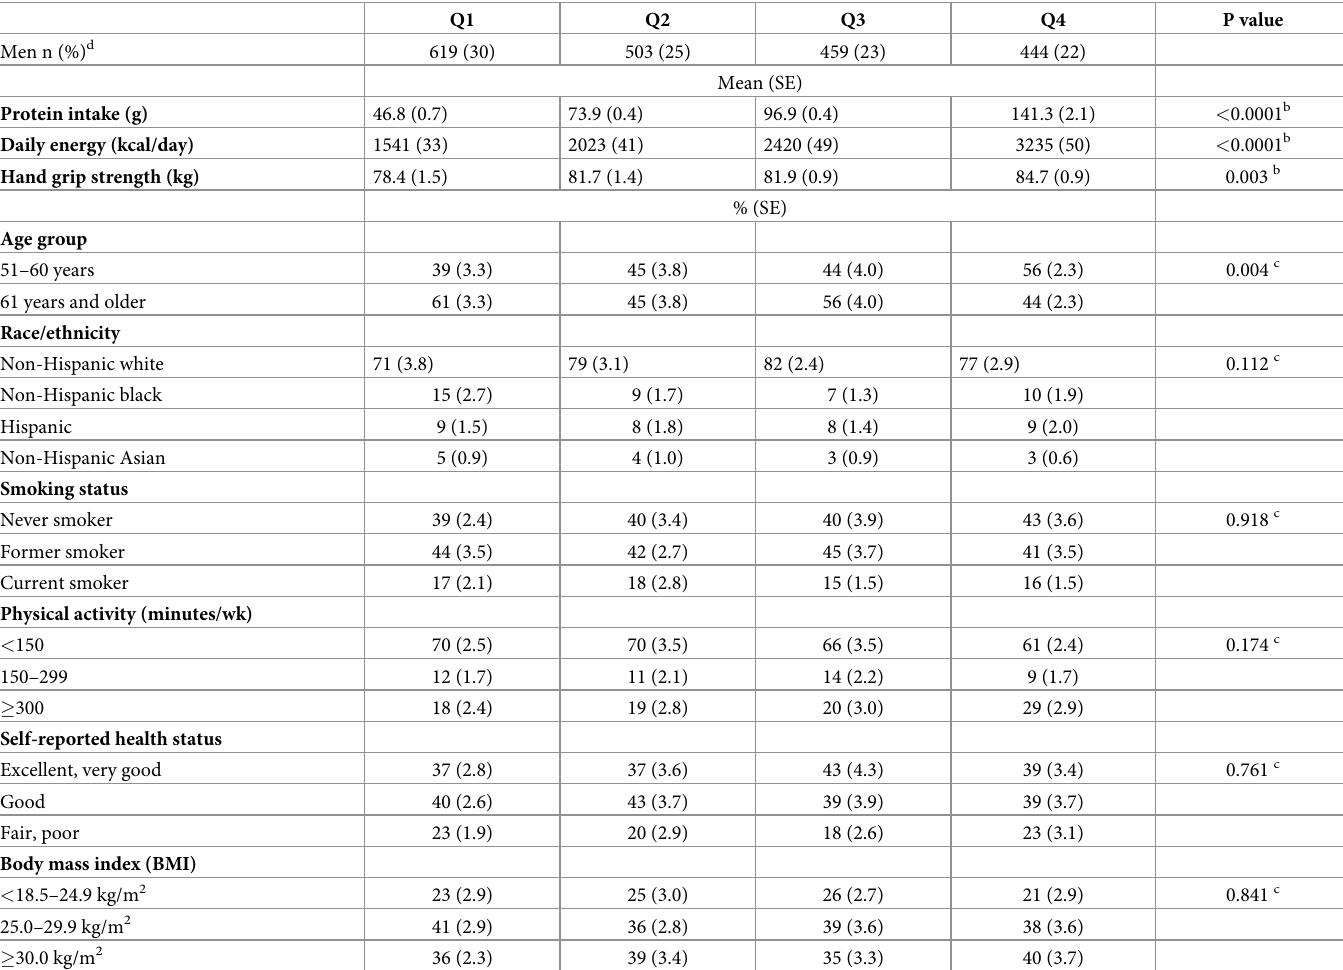
Table 1. Distribution of selected characteristics by quartile of daily protein intake in men a